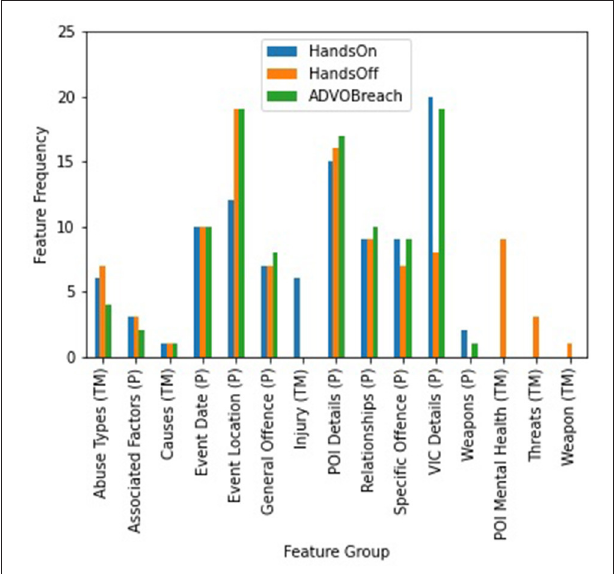
FIGURE 3 | Highest ranking feature categories returned from a chi-square test for the offense types to be predicted from police recorded FDV events. P refers to the fixed field (e.g., premise type, general offense, POI sex) data while TM refers to text mined information (e.g., abuse types, victim injuries).